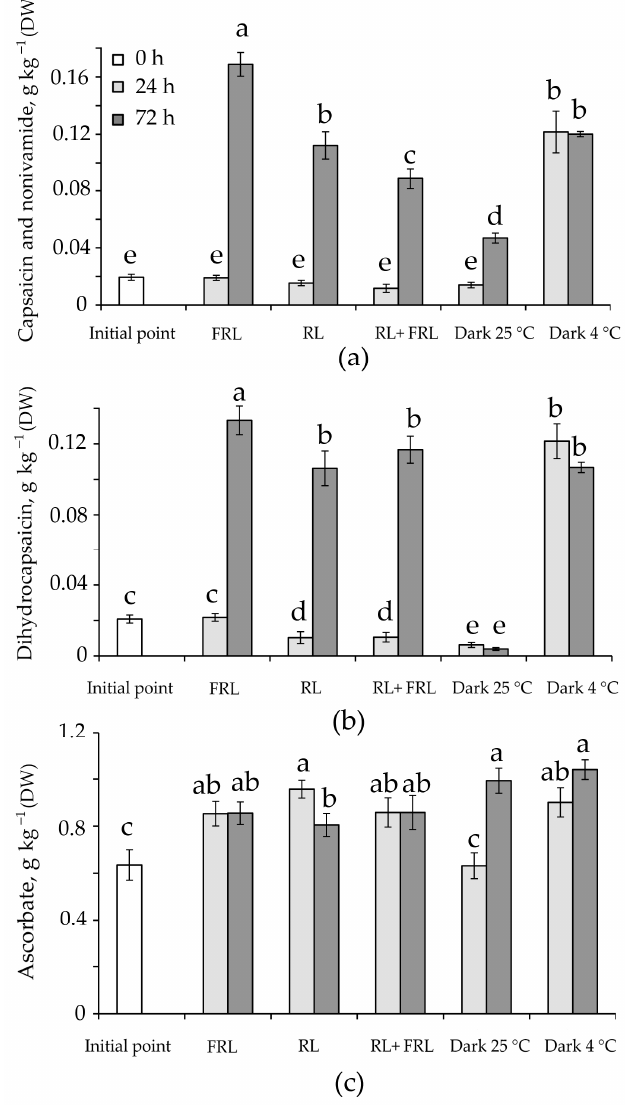
Figure 2. The content of the main capsaicinoids, capsaicin and nonivamide ( a ), dihydrocapsaicin ( b ), and ascorbate ( c ) under the influence of RL, FRL, and a low temperature in C. annuum fruit after 24 and 72 h. Different letters indicate significant differences ( p < 0.05) between the experimental treatments. The means ± standard errors, n = 3.